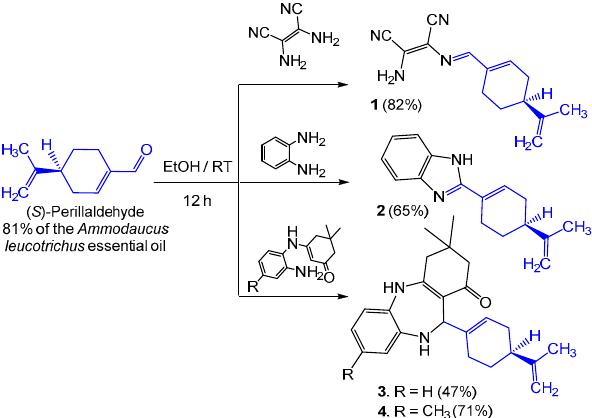
Scheme 1. In situ hemi-synthesis of imine 1 , benzimidazole 2 and benzodiazepines 3 – 4 from the